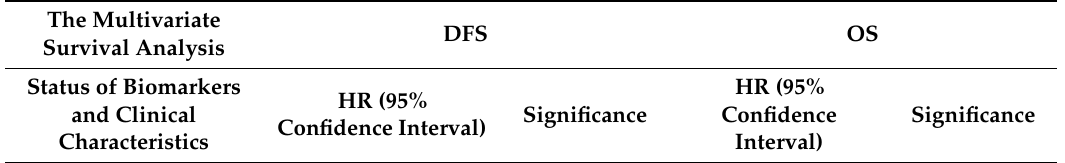
Table 3. The multivariate analysis of disease free survival (DFS) and overall survival (OS) of patients undergoing liver surgery.